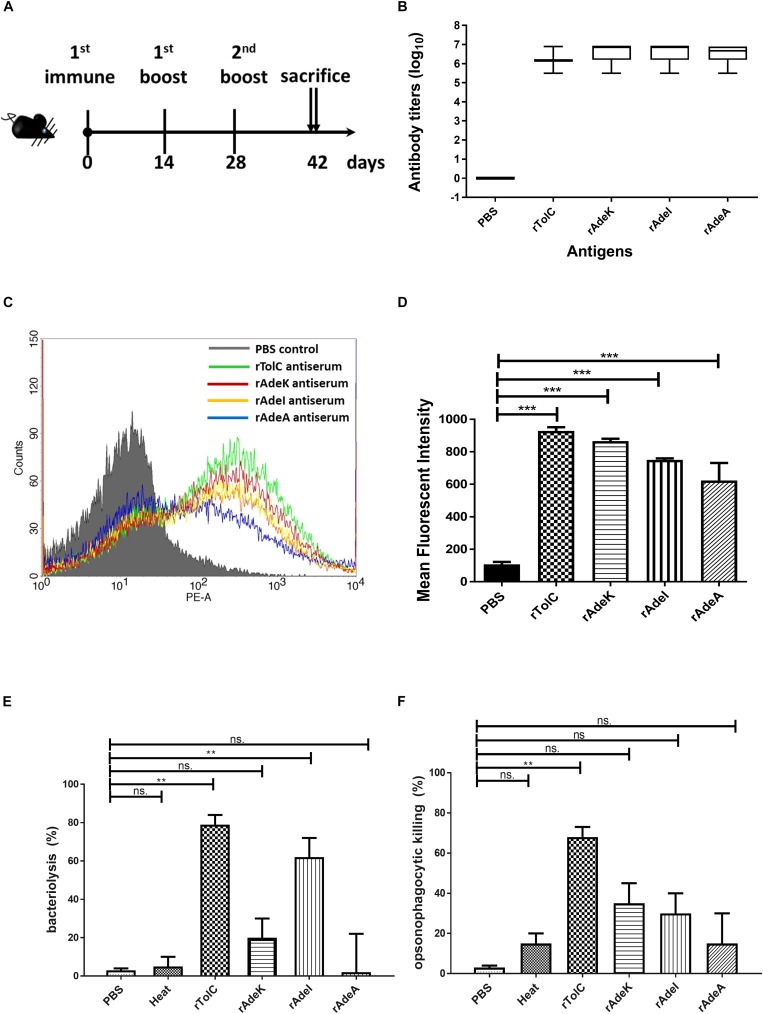
Polyclonal mouse antisera production and characterization. (A) Groups of C57BL/6 mice (n = 10) were subcutaneously immunized with either 10 μg of individual antigen (rAdeI, rTolC, rAdeK, and rAdeA) or phosphate-buffered saline (PBS) formulated with Complete Freund’s Adjuvant/Incomplete Freund’s Adjuvant (CFA/IFA) on days 0, 14, and 28. Blood samples were collected before sacrifice and tested against each antigen. (B) Serum IgG antibody titers against each antigen as indicated by enzyme-linked immunosorbent assay. (C) Flow cytometry (FACS) analysis demonstrating the surface accessibility of the antigen-specific antisera. Cells from late-log-phase cultures were probed with a control non-specific antibody (shaded histograms) or individual antisera (unshaded histograms). Each histogram shows the fluorescence intensity distribution of >20,000 flow cytometry events. (D) Histogram representing quantitative analysis of the binding intensity from FACS studies. Bars indicate the means of at least three independent experiments ± SEM. ***p < 0.001. (E) Bacteria inhibition by each antigen-specific mouse antisera at 1:10 dilution, used in the presence of human complement and ATCC17978. (F) The complement-dependent opsonophagocytosis assays were performed with mouse antisera (1:10), ATCC17978 and RAW 264.7 macrophages. The results represent the percentage of bacterial survival in the assay after 1 h of incubation at 37°C compared to that in phosphate-buffered saline (PBS)-Immunized antisera. Bars indicate the means of at least three independent experiments ± SEM. ns., non-significance. **p < 0.01, Heat, complement replaced with a heat-inactivated complement.